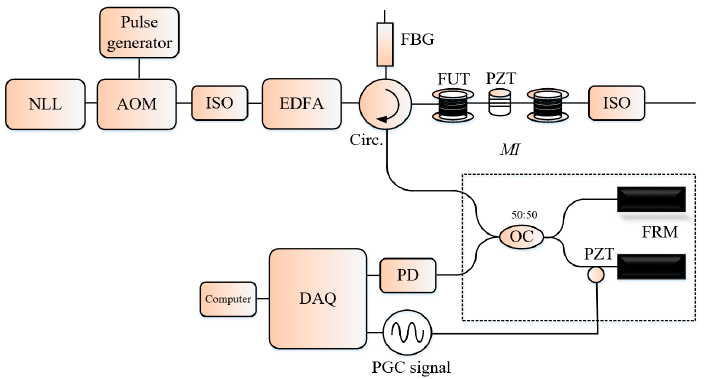
Figure 14. Setup of the Φ‐ OTDR with a MI at the receiving for generation of the PGC signal. FRM: Faraday rotation mirror.